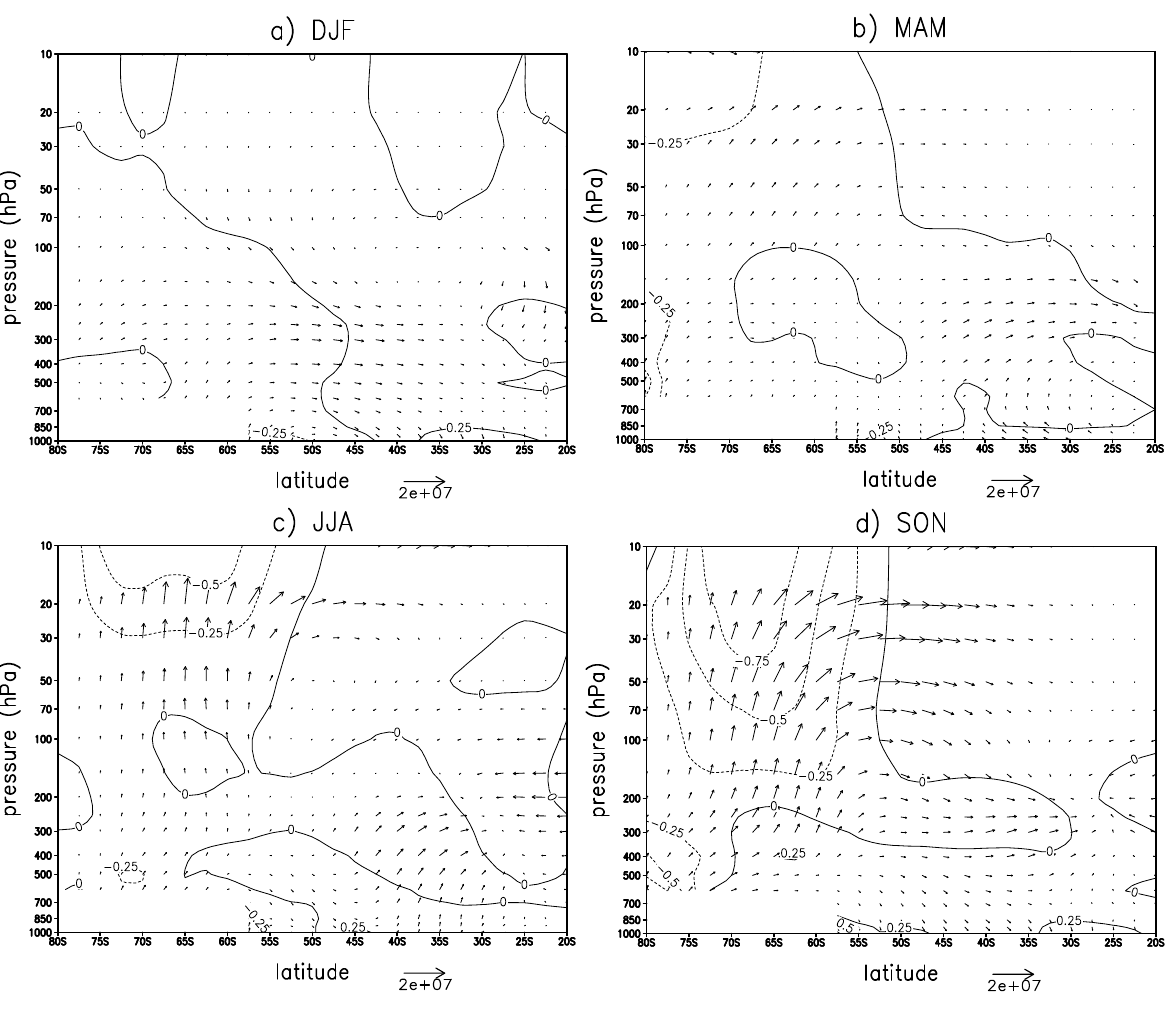
Fig. 5. Zonally-averaged EP flux cross sections for El Ni˜no composite minus the mean for: (a) DJF, (b) MAM, (c) JJA, and (d) SON. Lines indicate divergence of EP flux. The horizontal arrow scale for EP flux is in units of m 3 s − 2 and indicated at the bottom of the figures. The EP divergence contour interval is 0.25m s − 1 day − 1